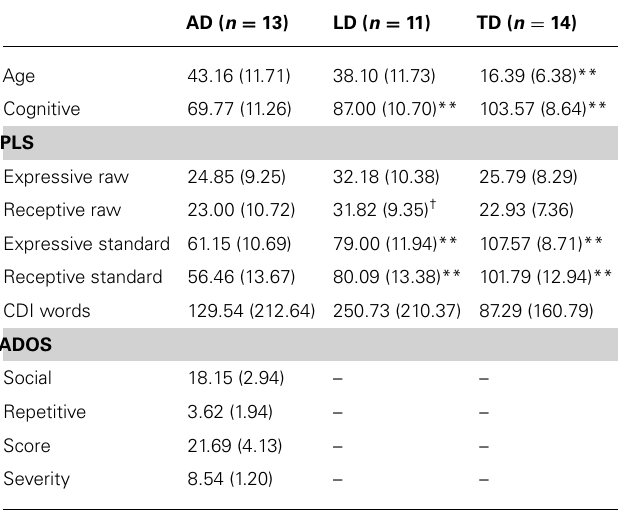
Table 1 |Test scores for autistic (AD) language delayed (LD) and typically developing (TD)